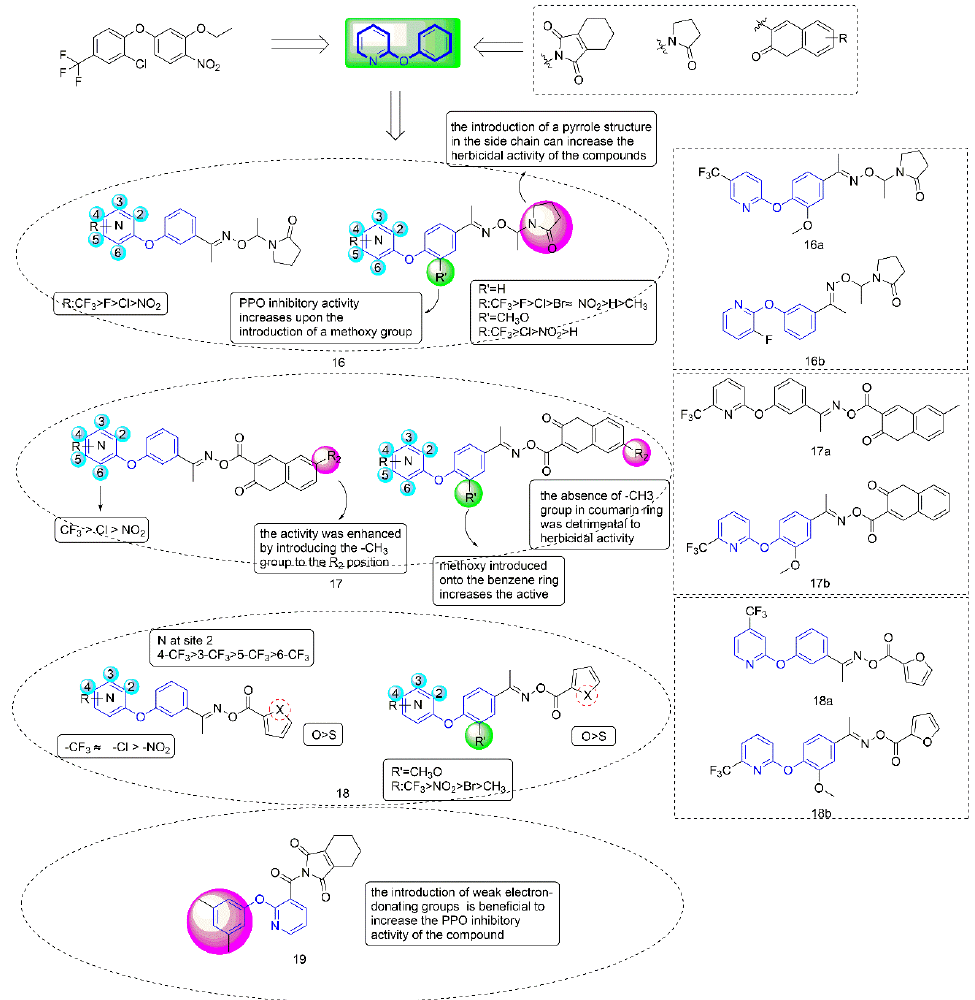
Figure 4. Protoporphyrinogen IX oxidase inhibitors containing phenoxypyridine.